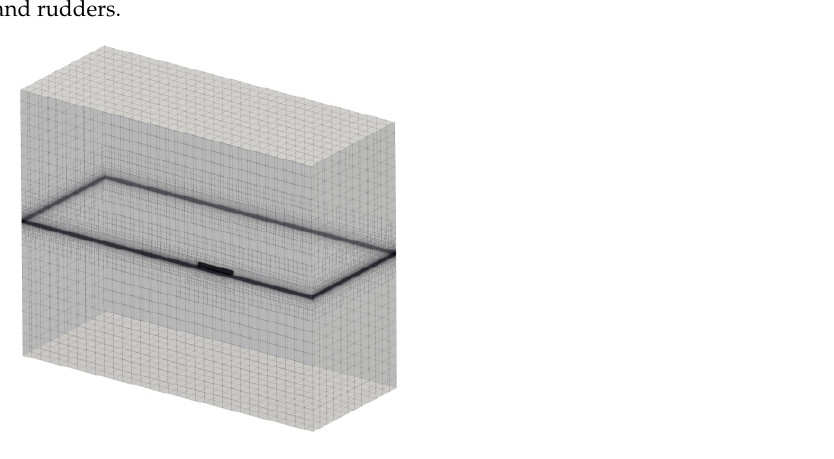
Figure 8. Generated mesh for the demihull with local refinements (cross sectional, lateral and bottom-up views) . 3.2. Discussion of Results The predicted full-scale values obtained by CFD simulations could be very well con- firmed by the physical test campaigns. The numerically predicted resistance and propul- sion power in full scale were well verified by the model experiments, with an error margin of 3% on average (see Figure 9). Figure 9 . Comparison on calm water resistance ( left ) and delivered power ( right ) per displace- ment between model tests and full scale CFD for the Stavanger Demonstrator . The predicted dynamic trim and sinkage by full scale CFD also show good agreement with the model experiments (see Figure 10). The observed stern-down trim of about one degree at the planned service speed of 23 knots is moderate, while the associated dynamic sinkage at the same speed is practically zero.